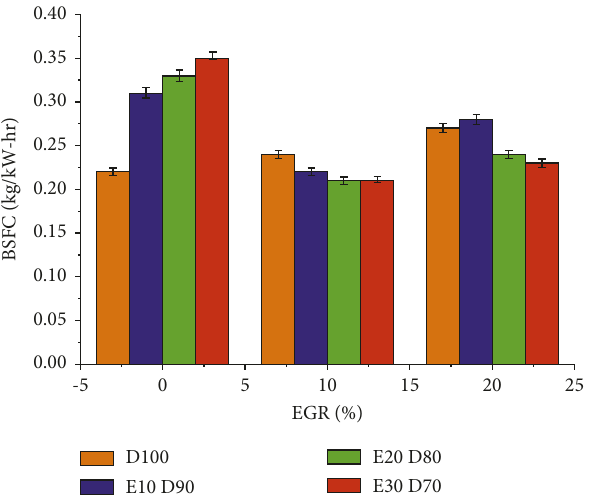
Figure 7: Ignition delay.